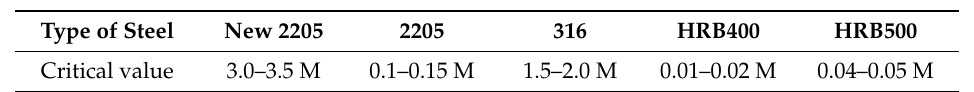
Table 2. Critical chloride concentrations of